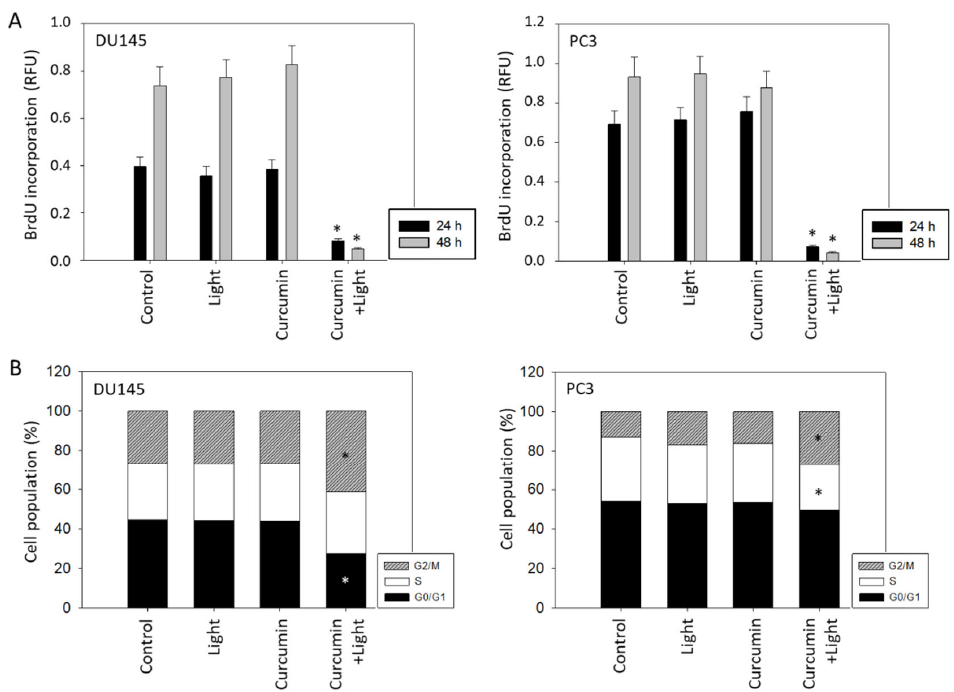
Figure 3. ( A ): BrdU incorporation under visible light exposure (5 min at 1.65 J/cm 2 ), application of curcumin (0.2 µ g/mL) or both curcumin and light irradiation. Controls remained untreated. Values are shown after 24 and 48 h incubation. Each experiment was done in triplicate and repeated 5 times. Data from one representative experiment is shown (n = 6). Error bars indicate standard deviation. ( B ): Influence of curcumin, light or curcumin plus light on proportionate G0/G1 ‐ , S ‐ , and G2/M ‐ phases of the cell cycle in DU145 and PC3 cells (24 h incubation) (n = 3; * indicates significant difference to untreated controls).